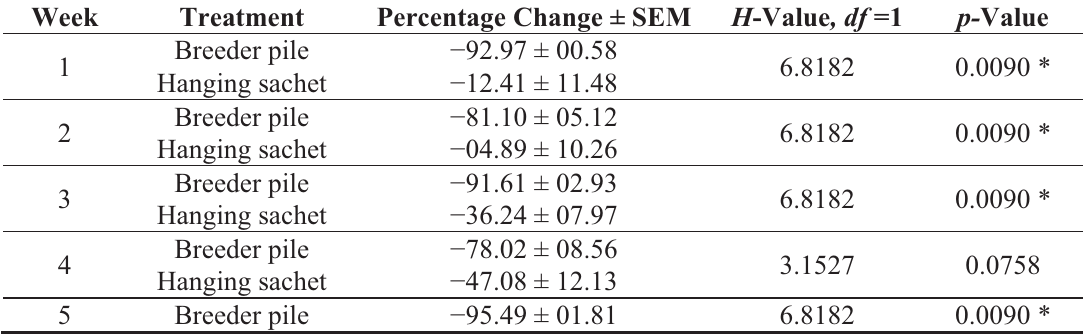
Table 3. Percentage change ± SEM of mean T. putrescentiae densities in treatments after introduction in experiment 1, trial 1. * indicates significant differences between treatments (Kruskal- Wallis, α =